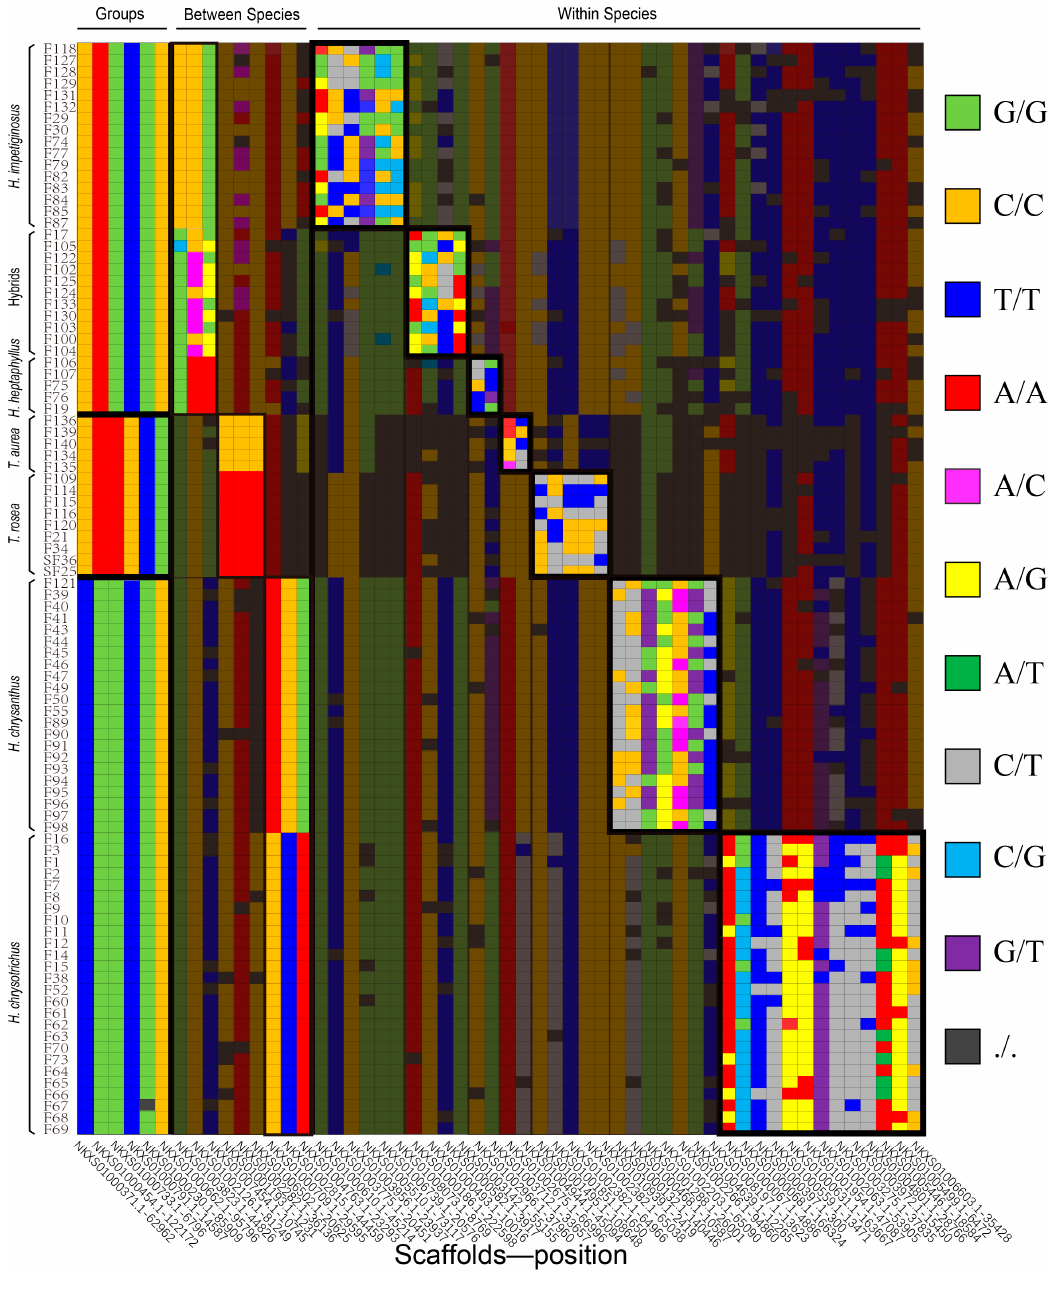
Figure 5. A fingerprint with only 54 SNPs of 94 sample individuals.